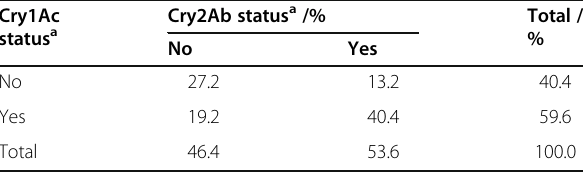
Table 5 Bt status of seeds in Bt-cotton fields Cry1Ac status